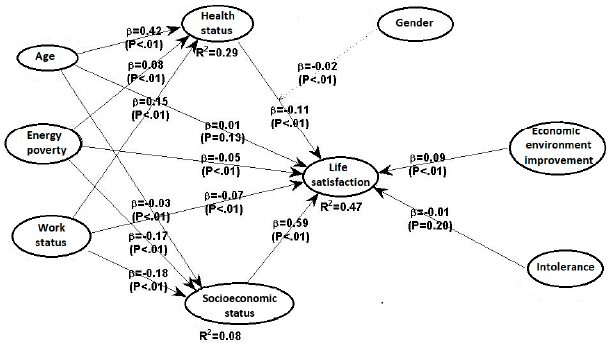
Figure 2. The estimated structural